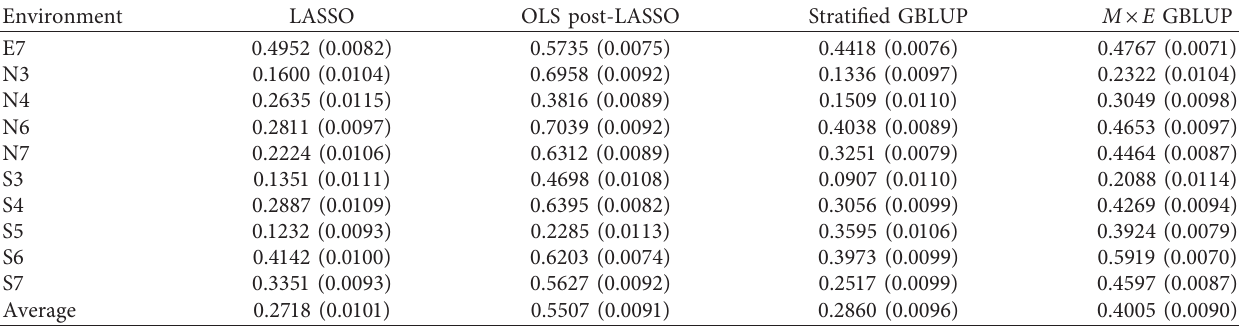
Table 5: The prediction accuracy (standard deviation, SD) of four methods for SY.